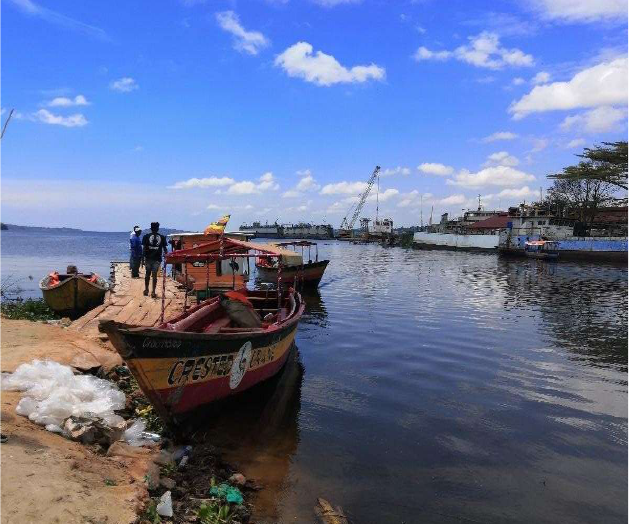
Figure 1. Port Bell, L. Victoria, Uganda. Engine-operated boats and plastic pollution are visible in the fore ground while the ferries appear in the background.